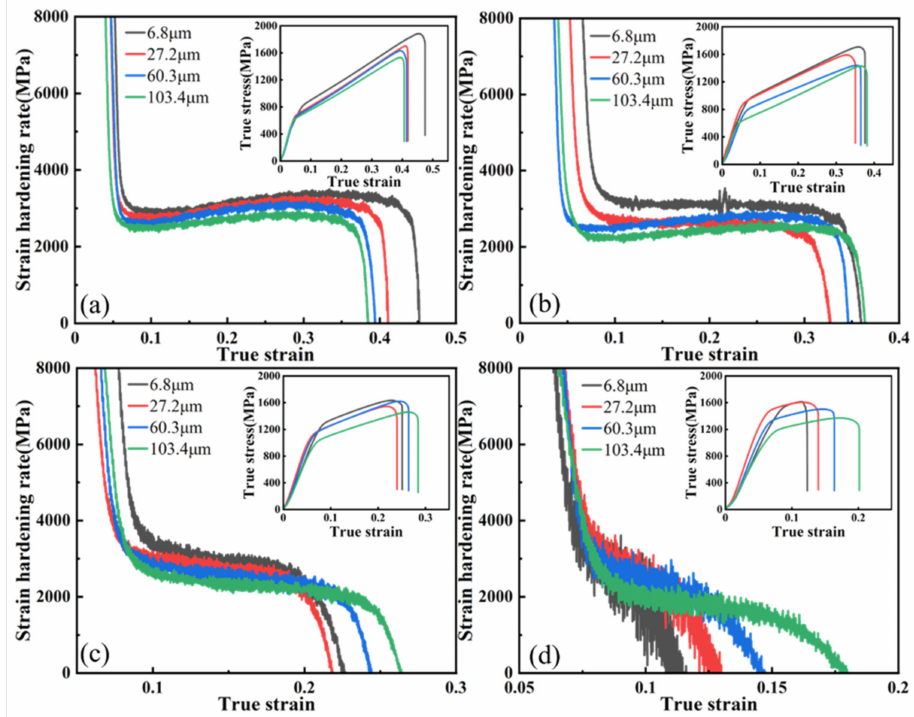
Figure 4. Strain hardening rate curves and true stress-strain curves of the studied samples at different reduction: ( a ) 10%; ( b ) 20%; ( c ) 30%; ( d )